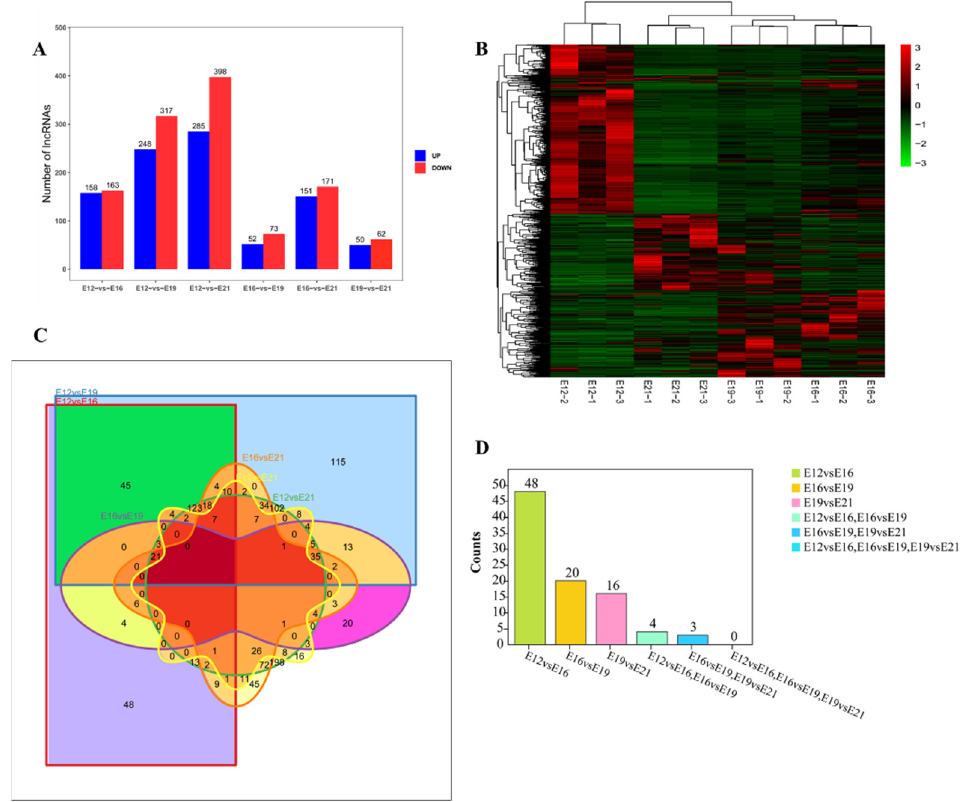
Figure 2. Differential expression of lncRNA analysis. ( A ) The number of lncRNAs differentially expressed at different times, including up-regulation and down-regulation; ( B ) differential lncRNA cluster analysis; ( C ) Venn diagram of six comparisons of differentially expressed lncRNAs; ( D ) stage difference gene statistics.